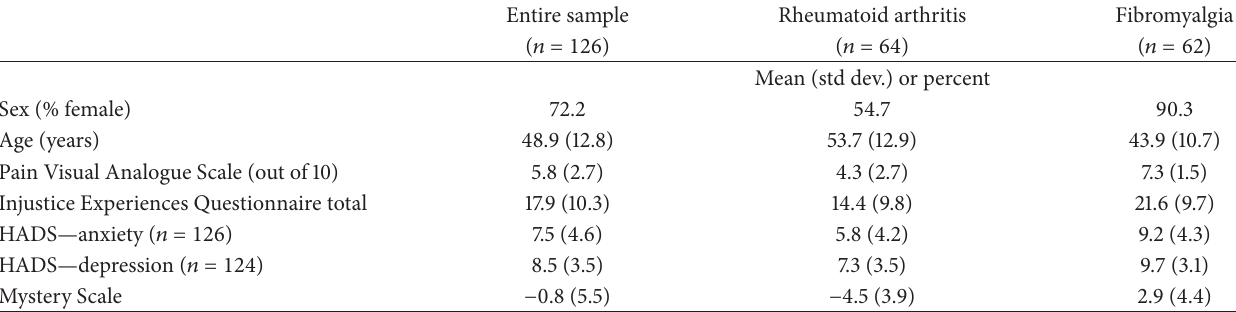
Table 1: Patient characteristics according to diagnostic